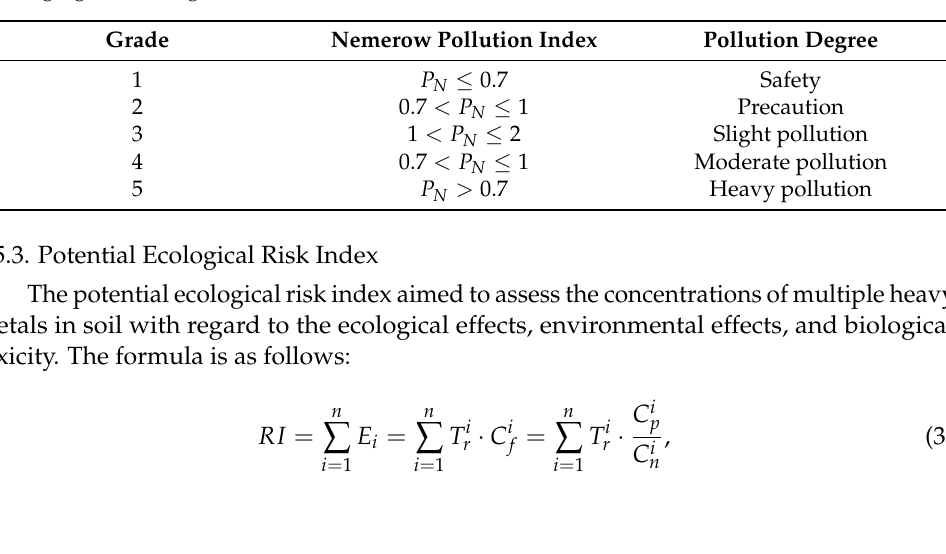
Table 2. Risk control standard for soil contamination of agricultural land and background values for soil (mg · kg − 1 ) in Jiangsu